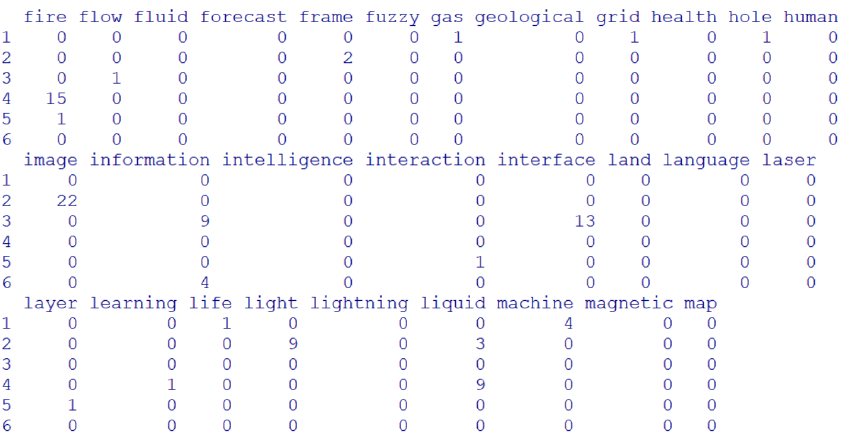
Figure 1. Part of structured patent